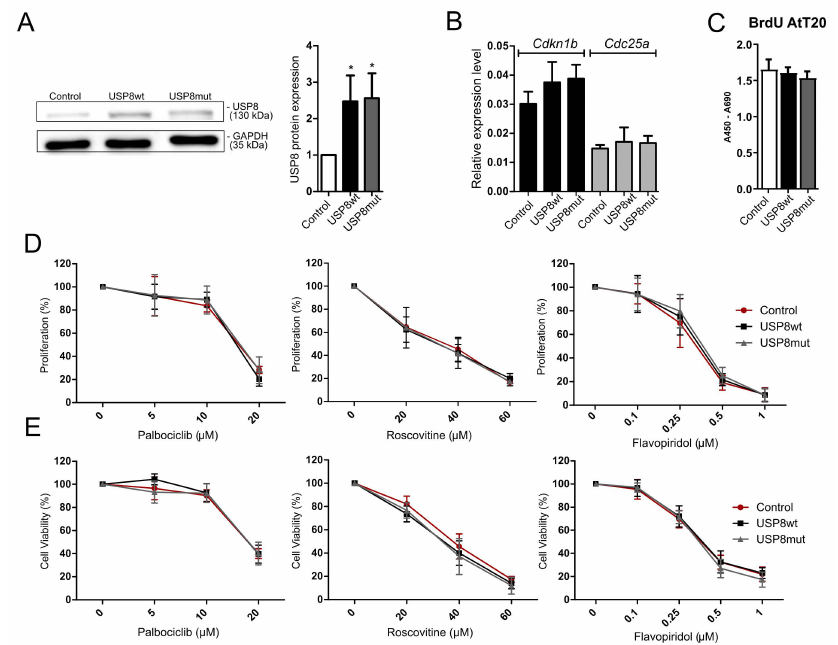
Figure 4. Treatment of AtT-20/D16v-F2 cells with overexpression of USP8 -mutated and wild-type variant with cyclin-dependent kinase inhibitors (CDKIs); Control—empty vector, USP8wt—wild type USP8 overexpression; USP8mut—overexpression of mutated USP8 . ( A ). Overexpression of mutated and wild-type Usp8 in AtT-20/D16v-F2 cells (Western blot membrane and densitometry results) * indicates p < 0.05; Original western blot figures can be found at Figure S1; ( B ). The expression levels of Cdkn1b and Cdc25a in AtT-20/D16v-F2 cells with overexpression of Usp8 -mutated and wild-type variants. Cdk6 and Ccnd2 expression levels in AtT-20/D16v-F2 cells were not determined since they were below qRT-PCR detection.; ( C ). Proliferation of AtT-20/D16v-F2 cells with overexpression of Usp8 -mutated and wild-type variants; ( D ). Proliferation rate of AtT-20/D16v-F2 cells with over- expression of USP8 -mutated and wild-type variants treated with CDKIs: palbociclib, roscovitine and flavopiridol, measured with the BrdU assay; ( E ). The viability of AtT-20/D16v-F2 cells with overexpression of Usp8 -mutated and wild-type variants treated with CDKIs: palbociclib, roscovitine and flavopiridol, measured with the MTT